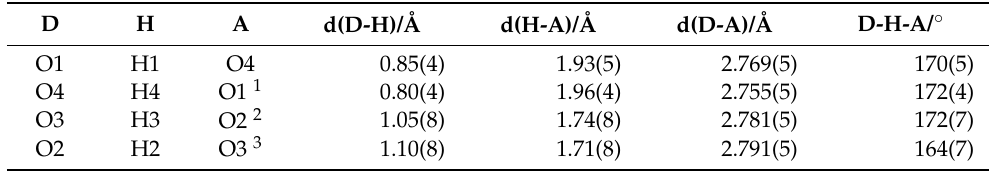
Figure 3. Hydrogen bonding among the THQ molecules in the crystal. Hydrogen atoms are not shown for clarity. Table 2. Hydrogen Bonds from crystal structure of THQ.